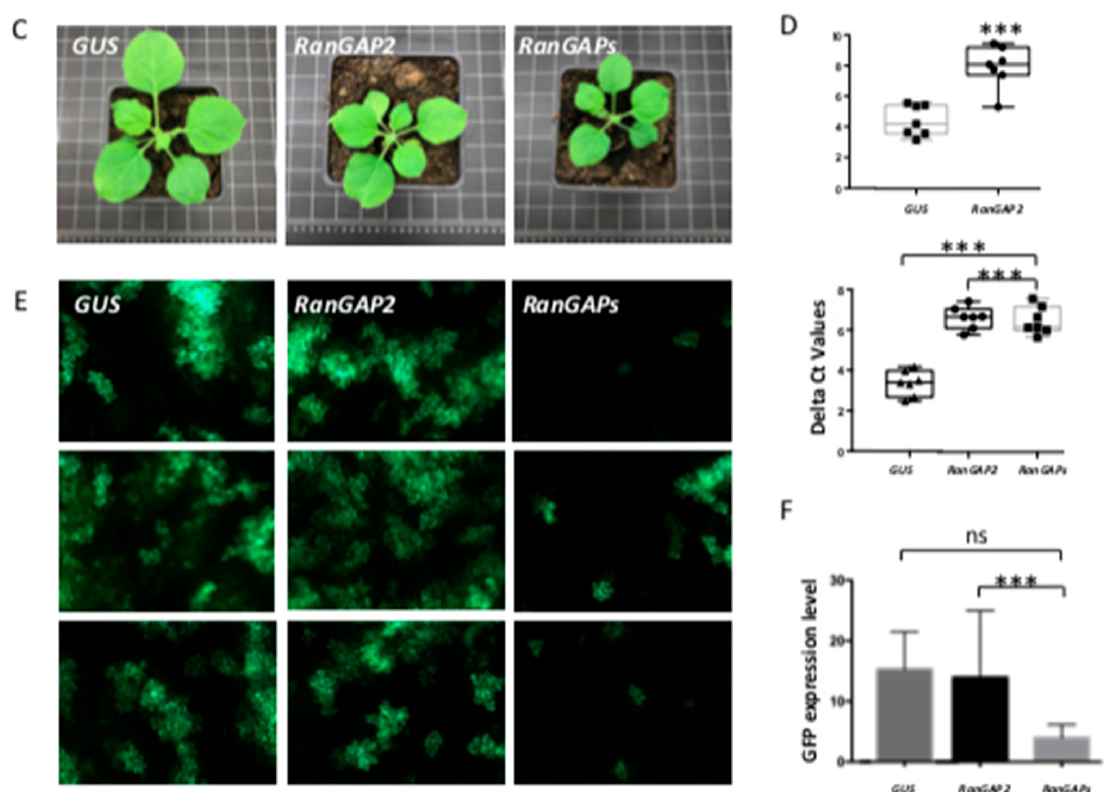
Figure 8. Co-localization analysis of TSWV and RSV N proteins with AtRanGAP2 and the effect of RanGAP silencing on TSWV replication. ( A ) Localization of RSV and TSWV N-GFP protein relative to AtRanGAP2-mcherry in plant cells. Bar presents 10 µ m. ( B ) Localization of RSV and TSWV N-GFP protein relative to WPP-NLS-mcherry in plant cells. Bar presents 10 µ m. ( C ) Plant phenotype after VIGS-silencing RanGAPs , compared with the GUS -silenced control plant. ( D ) qRT-PCR assay to quantify the silencing efficiency. *** p -value < 0.001. Delta Ct values are shown on Y-axis. ( E ) Green fluorescence resulting from eGFP expression from a TSWV replicon in plants silenced on RanGAP (s), and control plants. Plants were infiltrated with TSWV-eGFP replicon constructs 2.5-week post silencing and harvested at around 60 hpi. ( F ) Statistical analysis of eGFP intensity in the silenced plants and control plants.